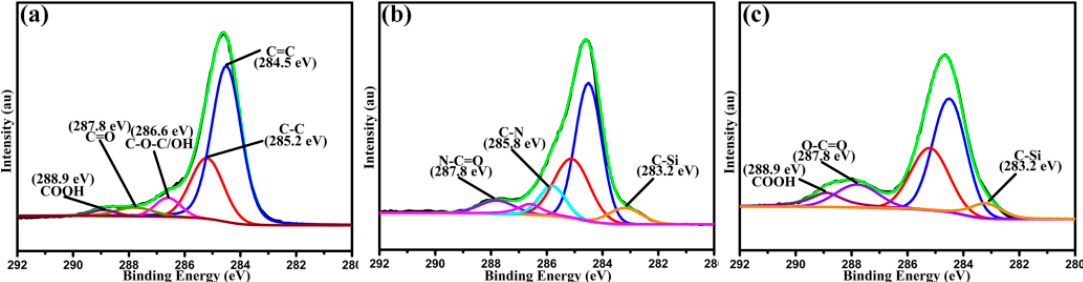
Figure 3. C1s high-resolution XPS peak-fitting curves of: ( a ) untreated CF; ( b ) CF–HNT–NH 2 ; and ( c ) CF–HNT–COOH.